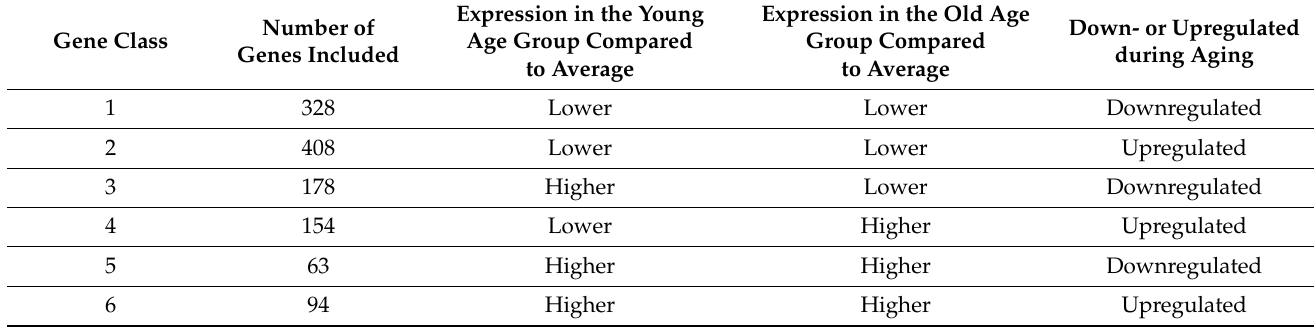
Table 1. Summary of differentially expressed genes (DEGs) by class. Gene class 1 and 2 correspond to DEGs with low expression compared to other genes in both young and old age groups. Gene class 3 and 4 correspond to DEGs with low expression compared to other genes in one group and a high expression in another group. Gene class 5 and 6 correspond to DEGs with high expression compared to other genes in both young and old age